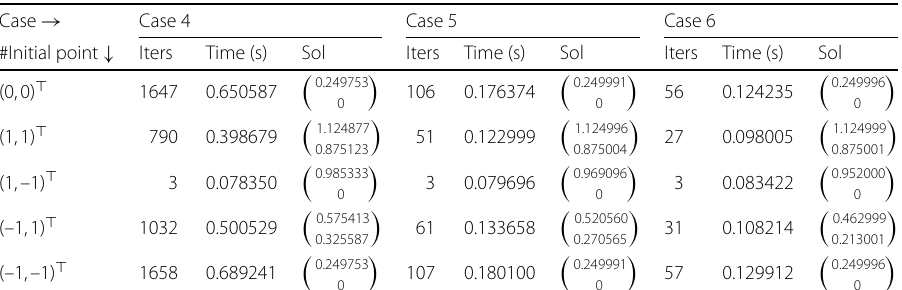
Table 2 Influence of the step size parameters β n and λ n (cases 4–6) of algorithm (3.1) for different